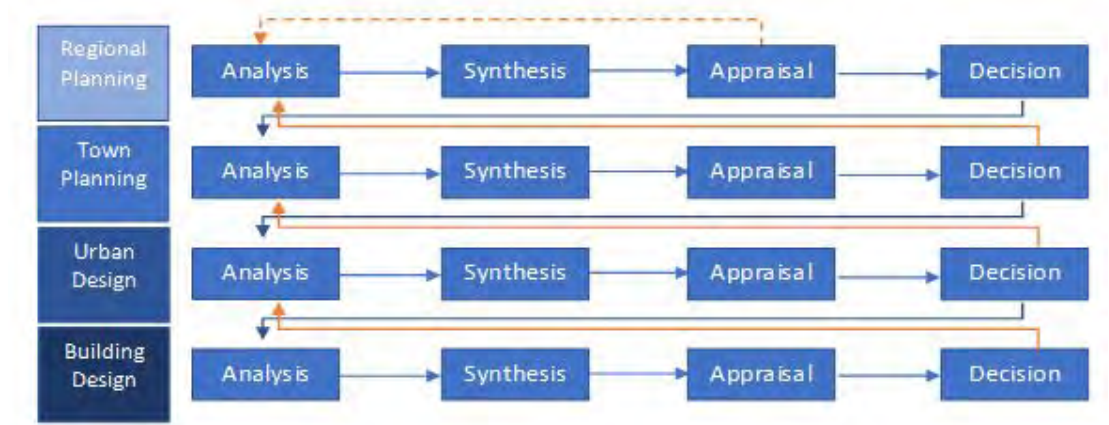
Figure 3. TheDesign Process for Urban Development (Moughtin, Cuesta, Sarris, & Paola,